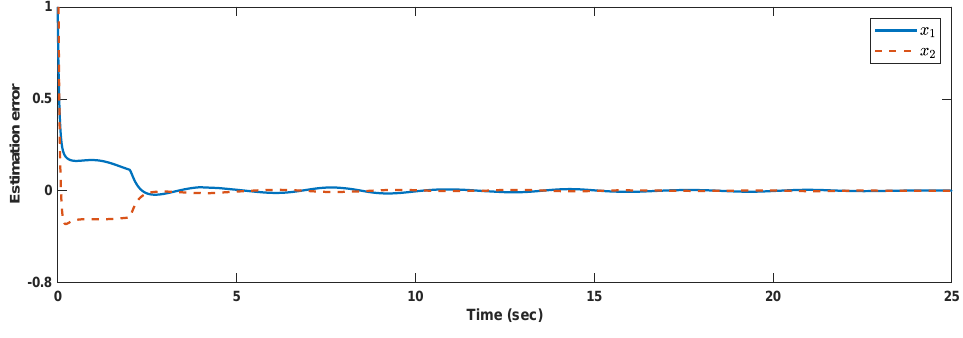
Figure 1. Example 1: Output trajectories.